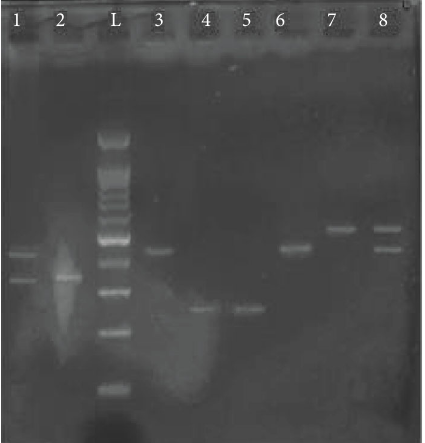
Figure 1: Various patterns of IL1Ragene polymorphism seen. 1 represents heterozygous 325 & 412bp IL-1Ra ∗ 4&1 variants; 2 represents homozygous 325bp IL-1Ra ∗ 4 variant; L represents 100-1500 bp ladder; 3 and 6 represent homozygous 412 bp